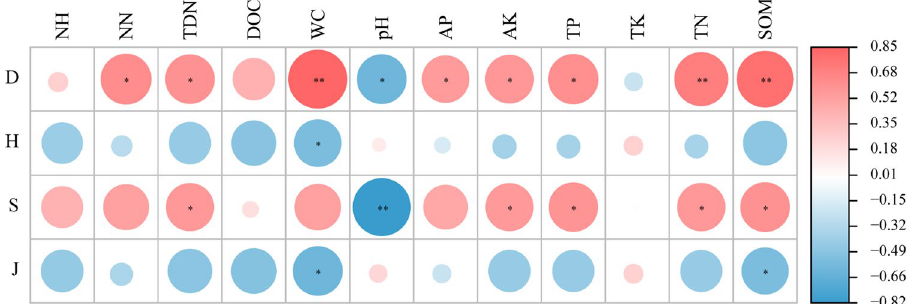
Figure 4. Pearson correlation coefficients between soil faunal diversity and soil factors. The species number (S) was transformed using log (x). H Shannon–Wiener index, D Margalef richness index, S species number, J Pielou evenness index, SOM soil organic matter, TN total nitrogen, TP total phosphorus, TK total potassium, AP available phosphorus, AK available potassium, TDN dissolved total nitrogen, DOC dissolved organic carbon, NH ammonium nitrogen, NN nitrate nitrogen, WC water content. Red represents a positive correlation; blue represents a negative correlation; the depth of color indicates the strength of the correlation. * P < 0.05, ** P < 0.01.